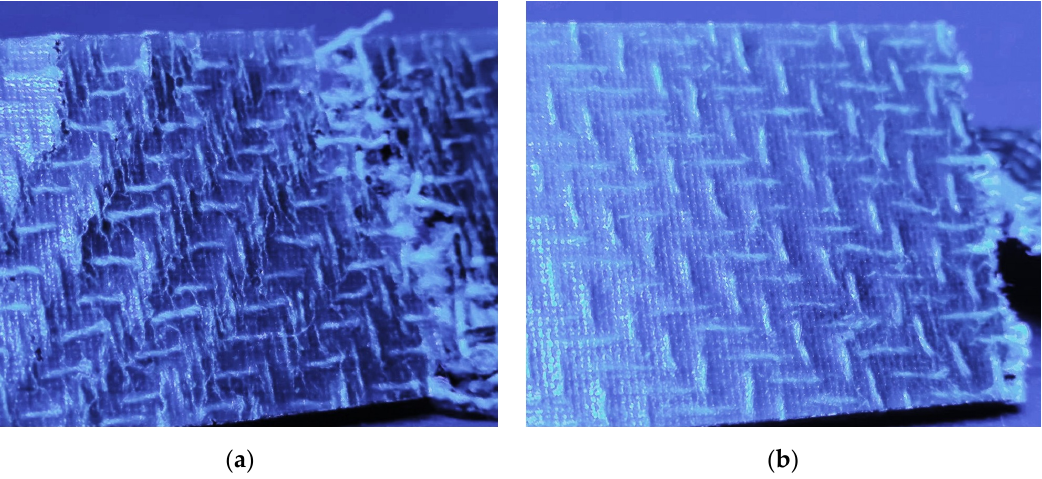
Figure 11. Fracture zones of selected tensile test specimens ( a ) in 0° (weft direction, above front view and below back view); ( b ) in 90° (warp direction, above front view and below back view).